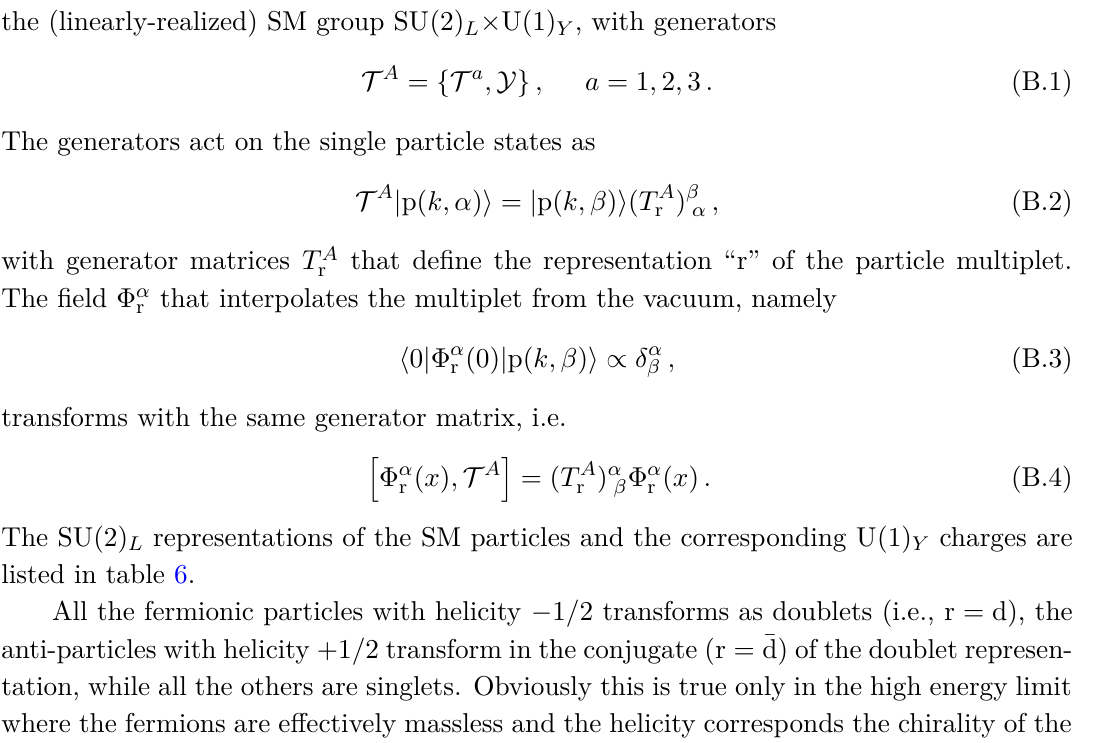
the (linearly-realized) SM group SU (2)